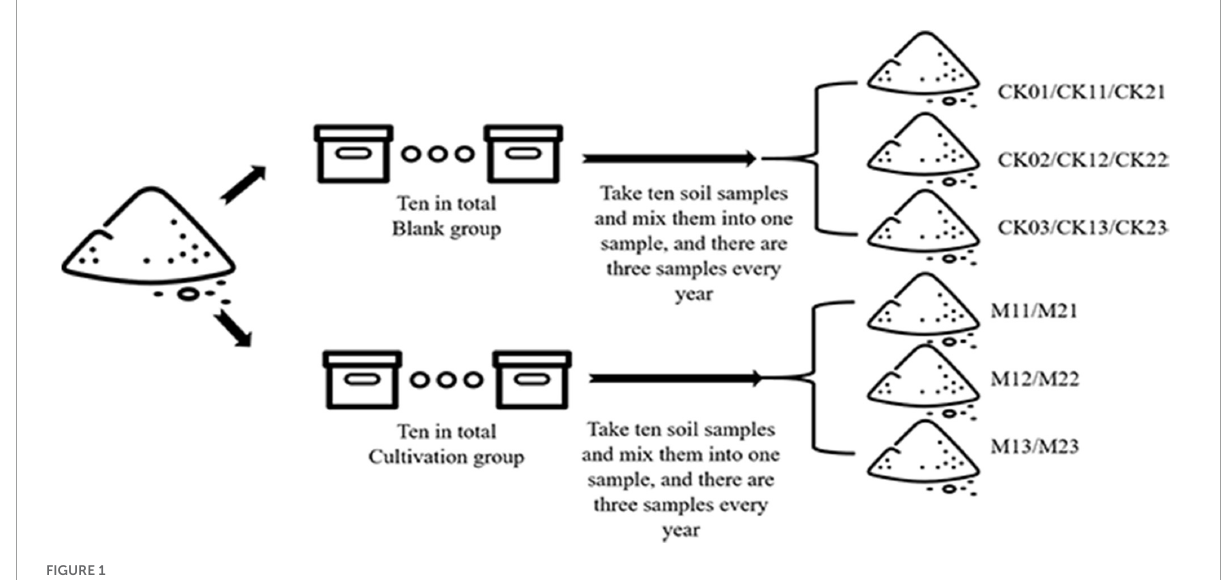
FIGURE1 Diagram of the experimental procedure.